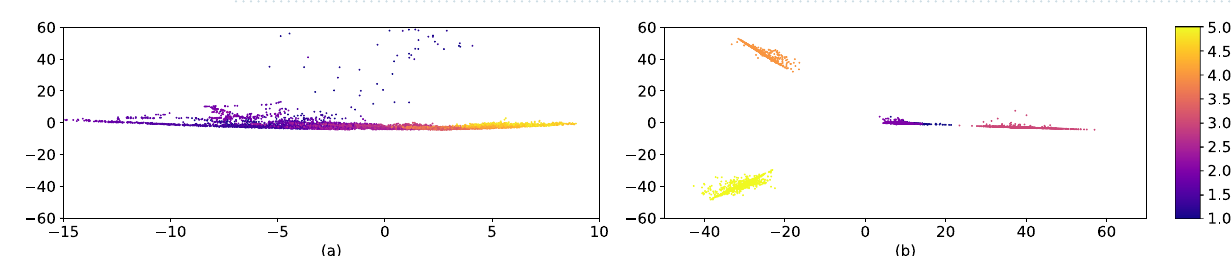
Figure 3. Interpretation in feature space. Each dot represents a sequence of bioelectrical signal in feature space obtained by executing PCA to the output of the forth convolutional layer from the end of BioeNet (see “Method” section for the detailed description of BioeNet). ( a ) Represents the case where the proposed training method is applied, while in ( b ) the network is trained as a typical classifier. The color represents the estimation of physiological state c ∈ [ 1, 5 ] . In ( a ), the distances among samples correspond well to their distance in real physiological states, while in ( b ) the continuity is broken, contradicting the fact that the physiological state should be continuous in